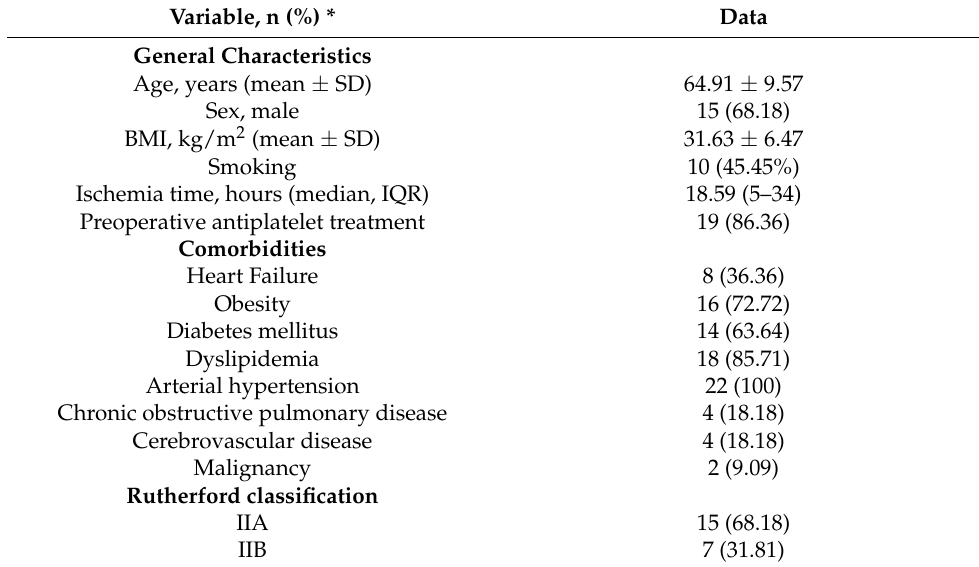
Table 1. Demographic data and patients’ characteristics.